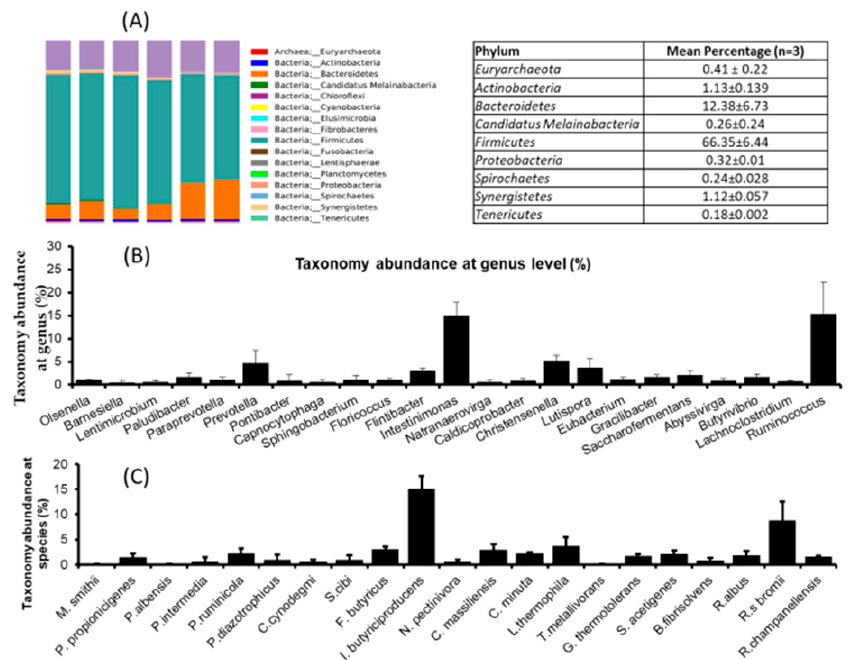
Figure 1. Microbial dynamics study of rumen fluids by pyrosequencing method. ( A ) Taxonomic abundances in rumen fluids at phylum level, ( B ) taxonomic abundances in rumen fluids at genus level, and ( C ) taxonomic abundances in rumen fluids at species level. The data are represented as mean ± STD, n = 3.